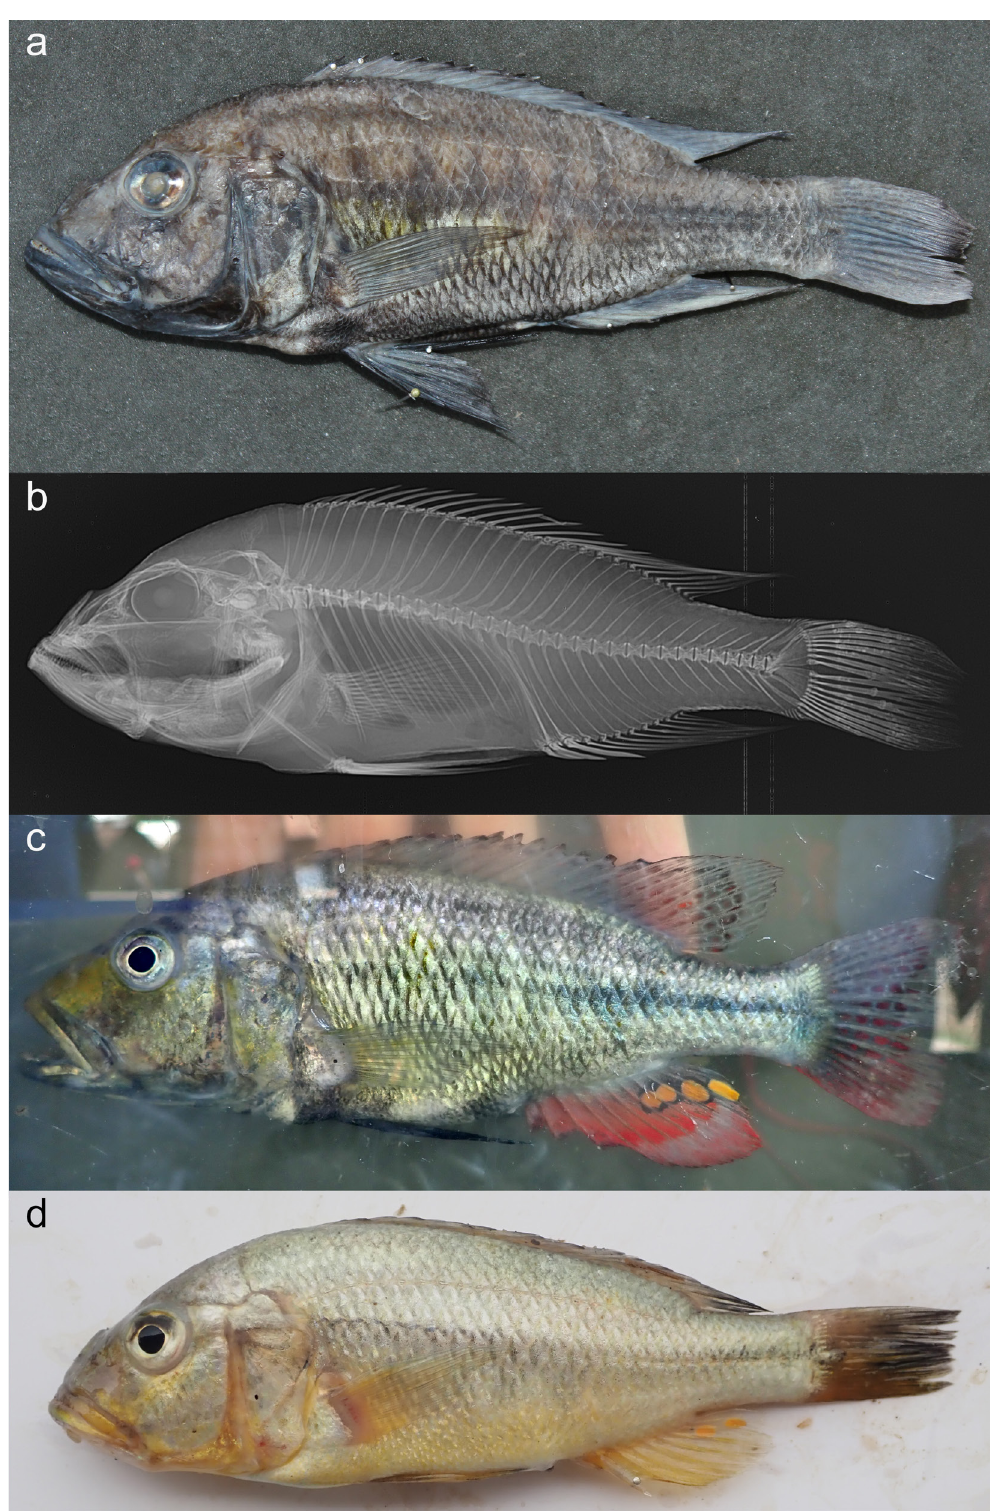
Fig. 24. Haplochromis kimondo sp. nov. a . Photograph of preserved holotype (RMCA 2019.002.P.0015; 152.4 mm SL). b . X-ray image of holotype. c – d . Photographs of freshly caught specimens. c . Holotype, a dominant male. d . Female (RMCA 2018.008.P.0364; 128.1 mm SL) to illustrate the live colour patterns. The contrast was slightly